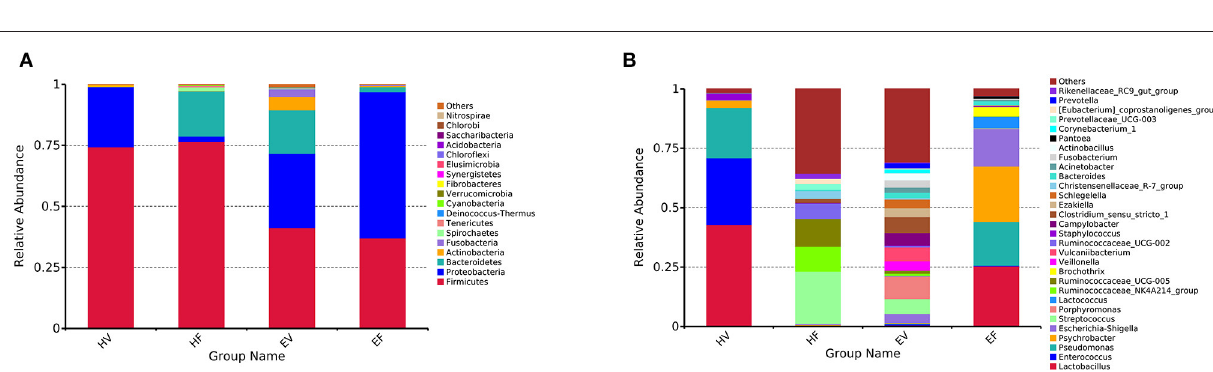
FIGURE 3 | The overall compositions of the microbiota of HF, HV, EF, and EV. The overall compositions of the microbiota of the healthy feces (HF), healthy vaginal secretions (HV), endometritis feces (EF), and endometritis vaginal secretions (EV) were represented as bar plots at the (A) phylum level and the (B) genus level. Each bar represents the average relative abundance of each bacterial taxon within a group. The phylum-level shows the top 20 rich taxa, and the genus level shows the top 30 rich